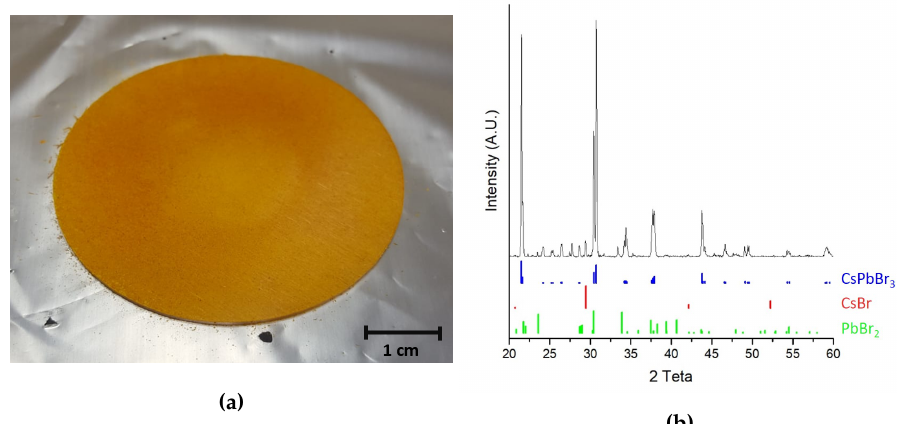
Figure 1. ( a ) Picture of the obtained perovskite target ( b ) XRD spectra of the obtained perovskite